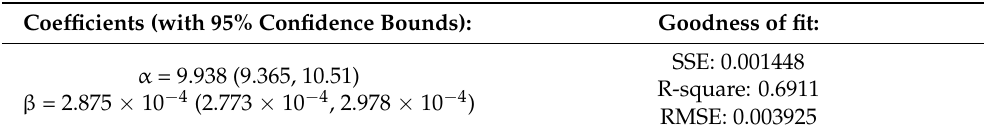
Table 7. Fi tt ing parameters for results in relation to Rayleigh damping. Table 7. Fitting parameters for results in relation to Rayleigh damping. Coe ffi cients (with 95% Con fi dence Bounds): Coefficients (with 95% Confidence